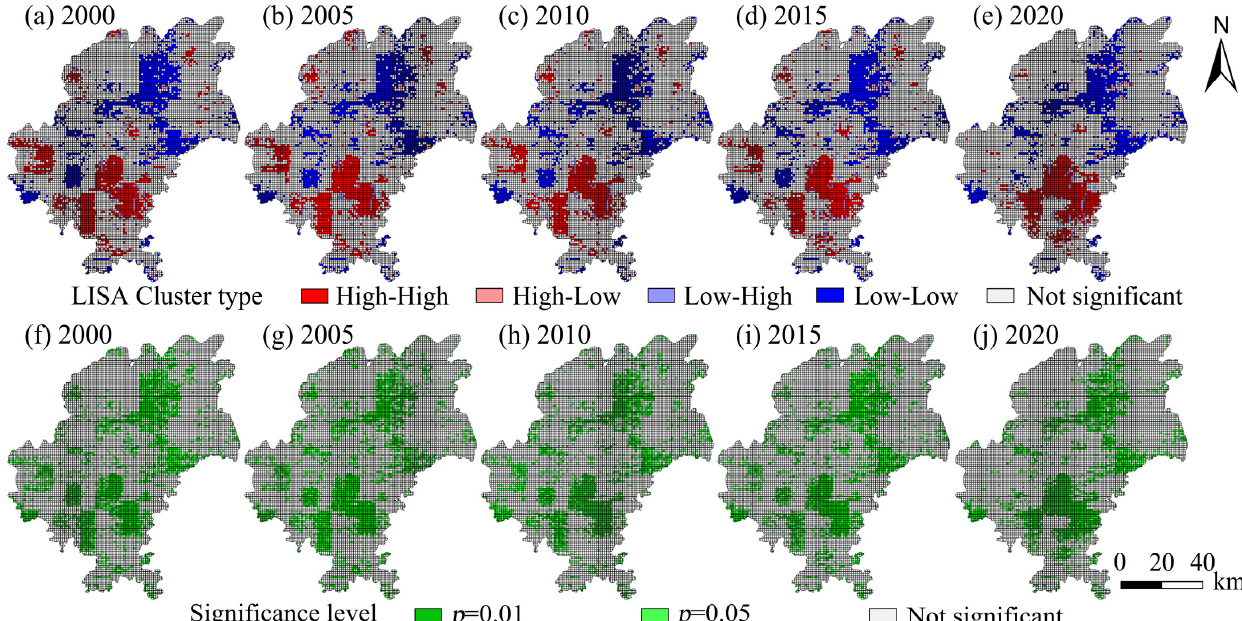
Figure 6. LISA clustering analysis and significance level of human activity intensity and habitat quality changes in Guiyang from 2000 to 2020.